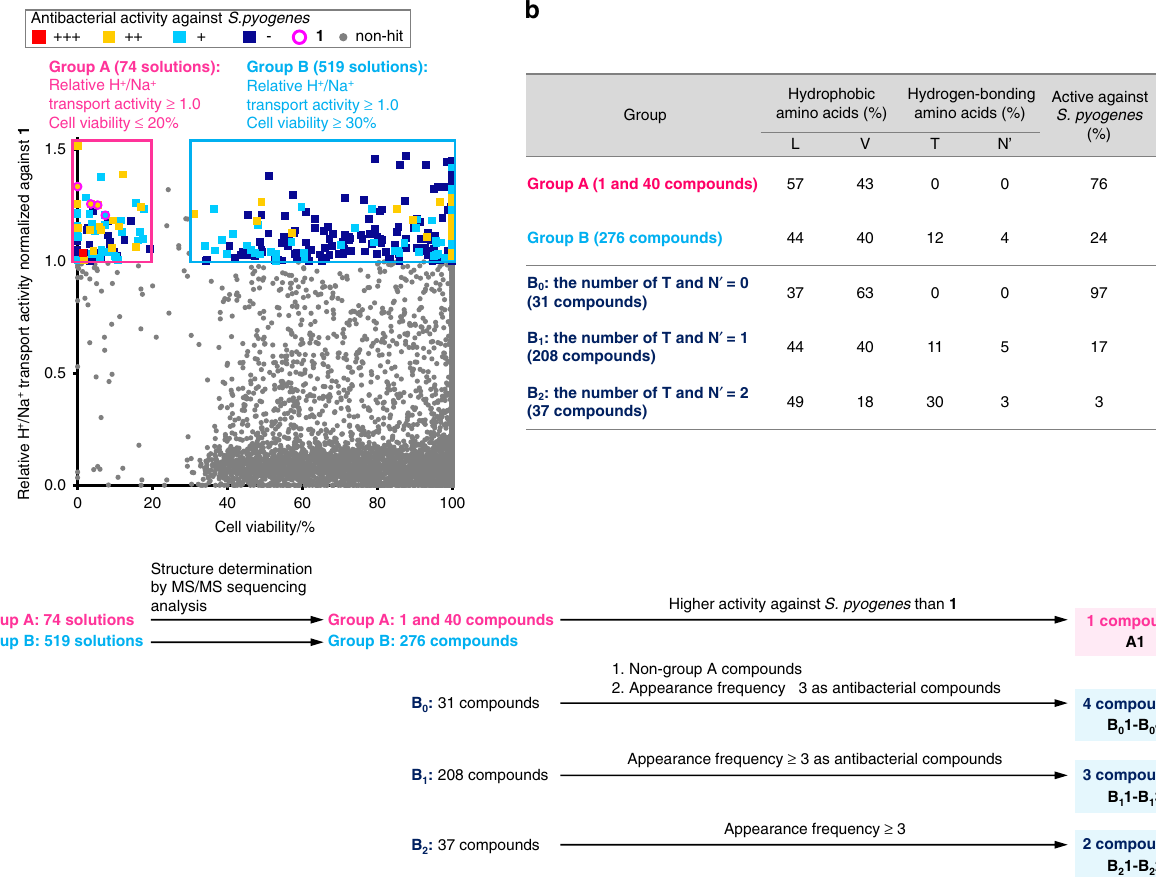
Fig. 3 Evaluation and classi fi cation of the 1-based OBOC library. a The scatter plot for the three different assays of the bead-derived 13,584 peptide solutions. H + /Na + transport activities of the peptides were normalized against the activity of 1 . Cell viability (%) was evaluated using the P388 mouse leukemia cell line. Antibacterial activity against S. pyogenes was evaluated using the three concentrations and the potency is coded by three colors. +++ (red square): inhibition by the 640-fold diluted peptide solution, ++ (yellow square): inhibition by the 160-fold diluted peptide solution, + (cyan square): inhibition by the 40-fold diluted peptide solution, - (navy square): no inhibition. The dots denoting the parent 1 are indicated by the purple circles. The dots that did not meet any criteria are shown as gray fi lled circles. Source data are provided as a Source Data fi le. b Distribution percentages of the randomized four amino acids and percentages of the active peptides against S. pyogenes . Amino acids are displayed as one-letter codes (Asm = N ′ ). Compounds were de fi ned as active if one or more solutions was active in the antibacterial assay. c Selection criteria of the 10 peptides ( A1 , B 0 1 – B 0 4 , B 1 1 – B 1 3 , and B 2 1 – B 2 2 ) from groups A and